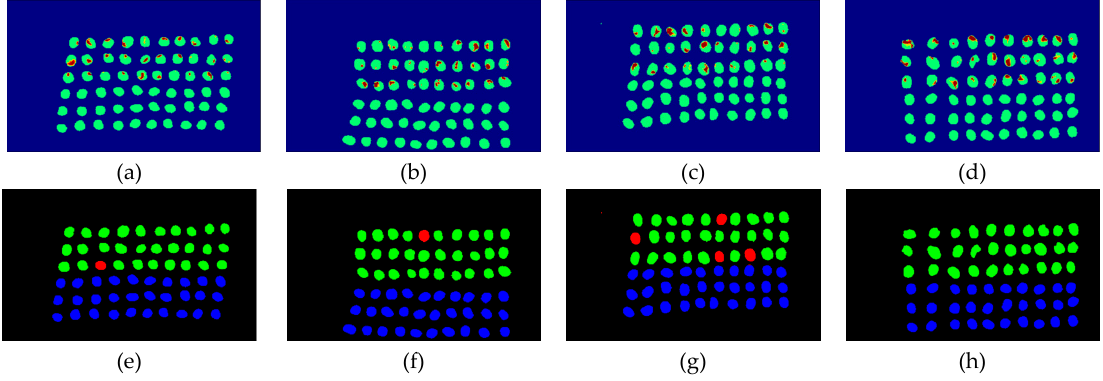
Figure 44. Results of green coffee bean CNN+CEM_BDM 20 bands. (a-d) CNN classification results, (e-h) final visual images.